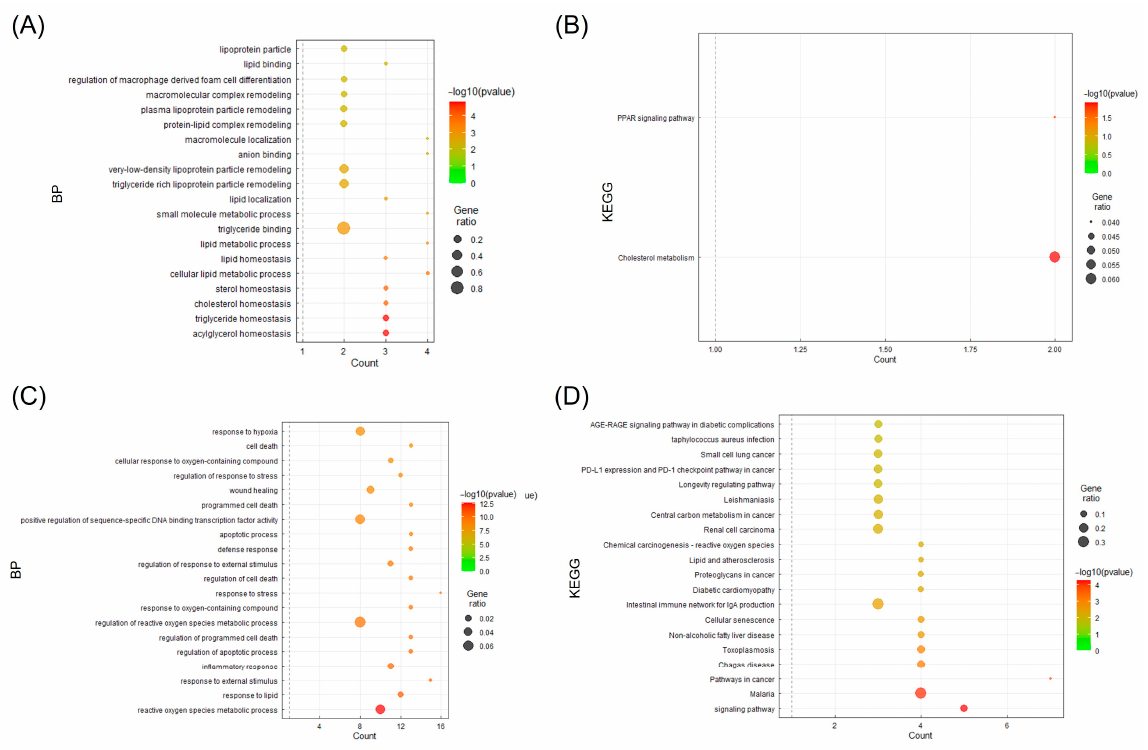
Figure 5. Bubble plot visualization of enrichment analysis (BP terms and KEGG pathways) from two target clusters from the herbal combination. Significant ( A ) BP terms and ( B ) KEGG pathways of target cluster 1. Significant ( C ) BP terms and ( D ) KEGG pathways of target cluster 2.